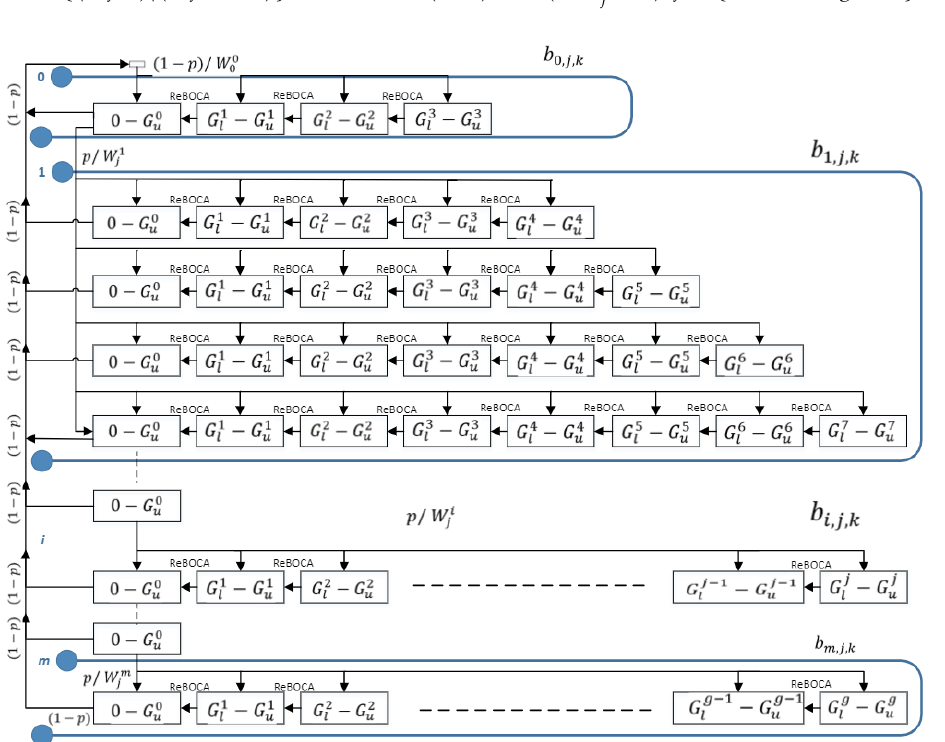
Figure 2. Discrete time Markov chain transition diagram of ReBOCA with sGW